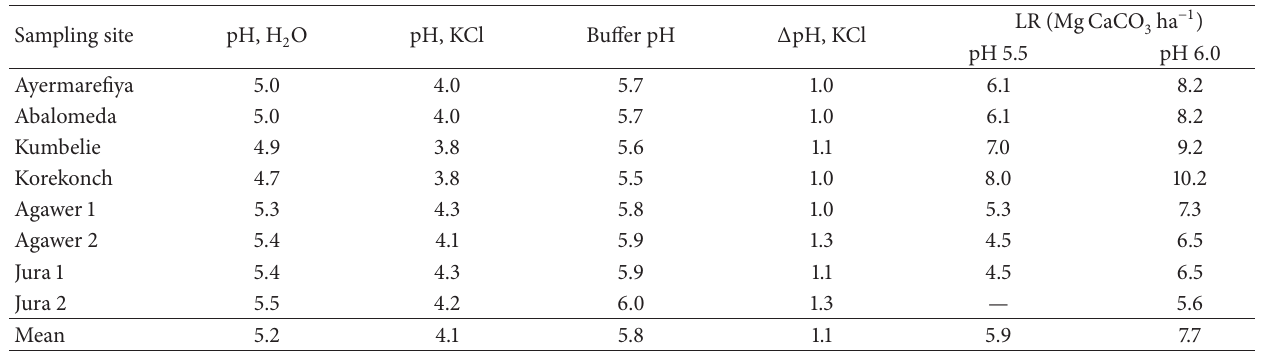
Table 3: Soil pH, buffer pH, and lime requirement (LR).